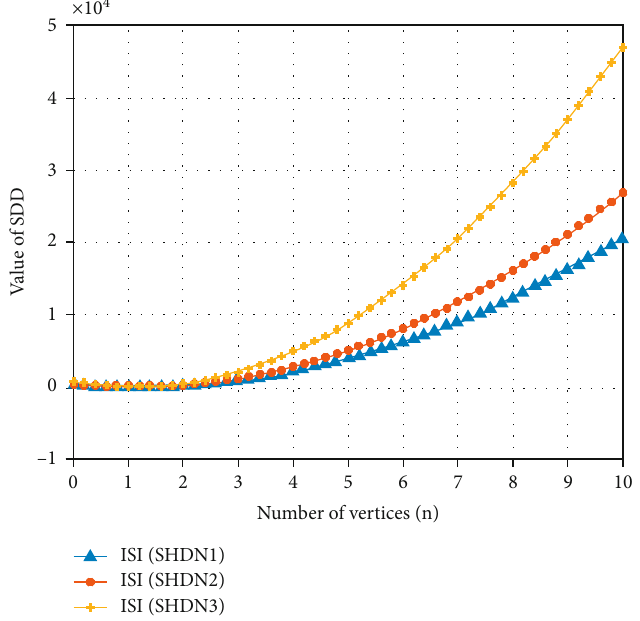
n Þ , Γ n Þ , and Γ n Þ using 2D graphs of SDD. 1 ð 2 ð 3 ð